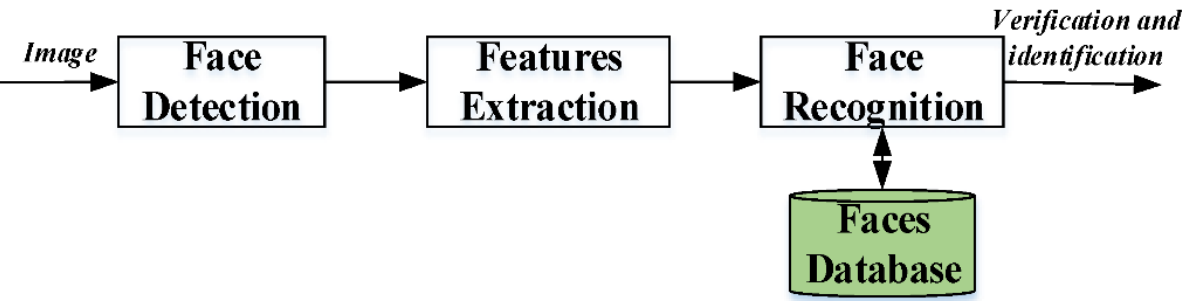
Figure 2. Face recognition structure. The figure has been taken from [39]